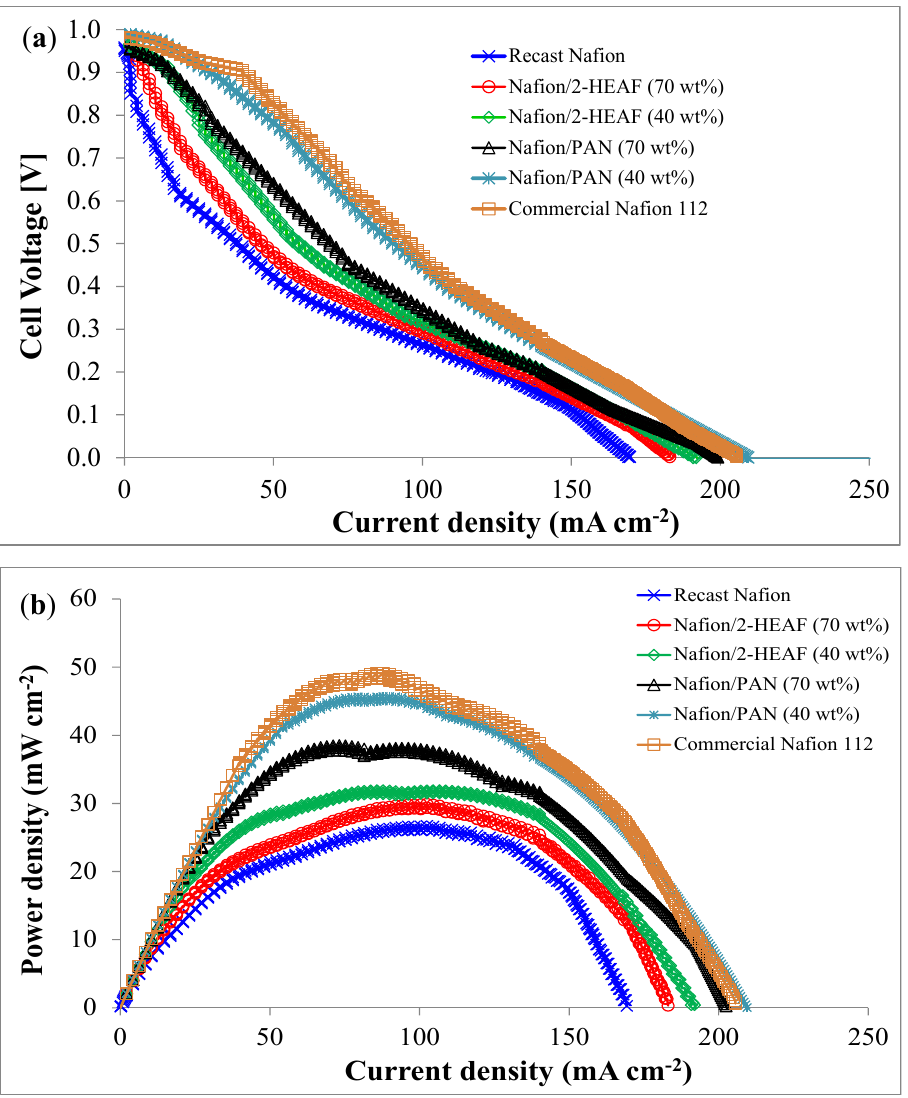
Figure 5. Single cell PEMFCs performance at different types of MEA using various synthesized membranes: ( a ) polarization curve and ( b ) power curve.